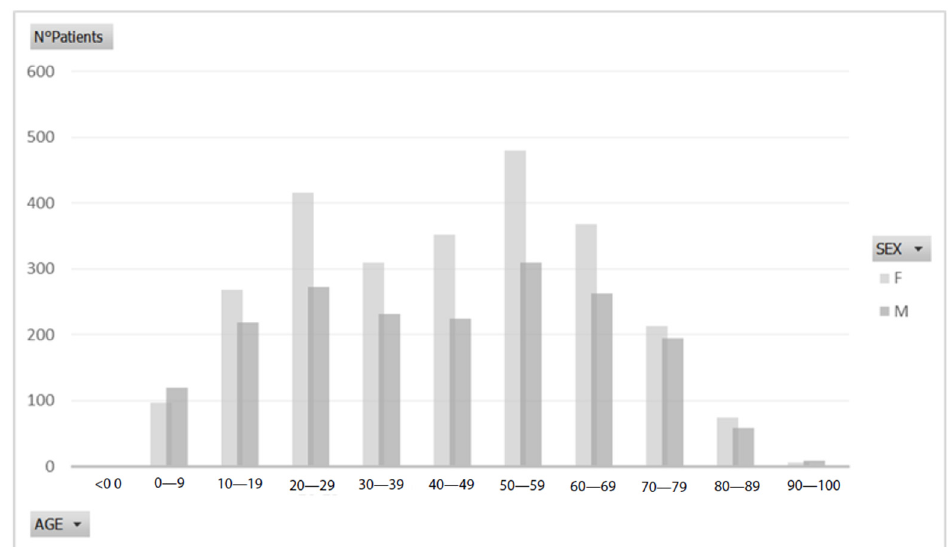
Figure 2. Demographic data.